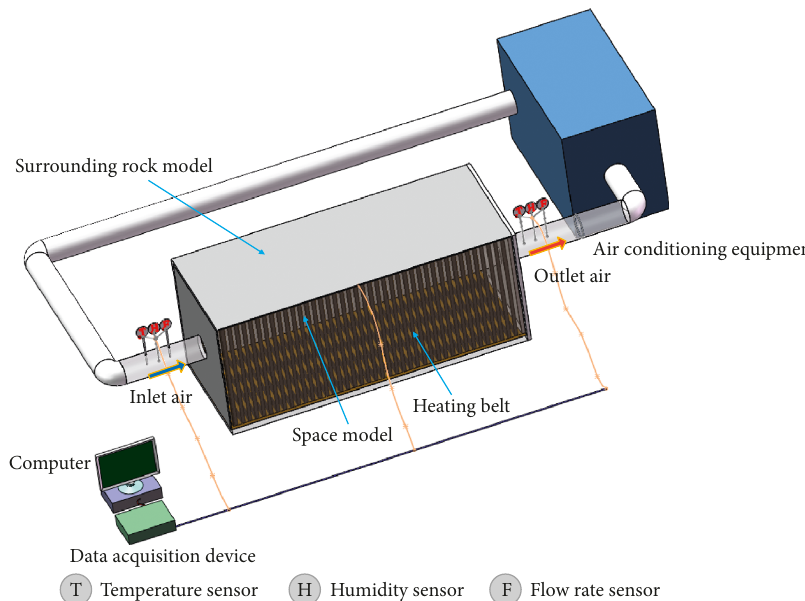
Figure 1: Schematic diagram of the experimental set up.